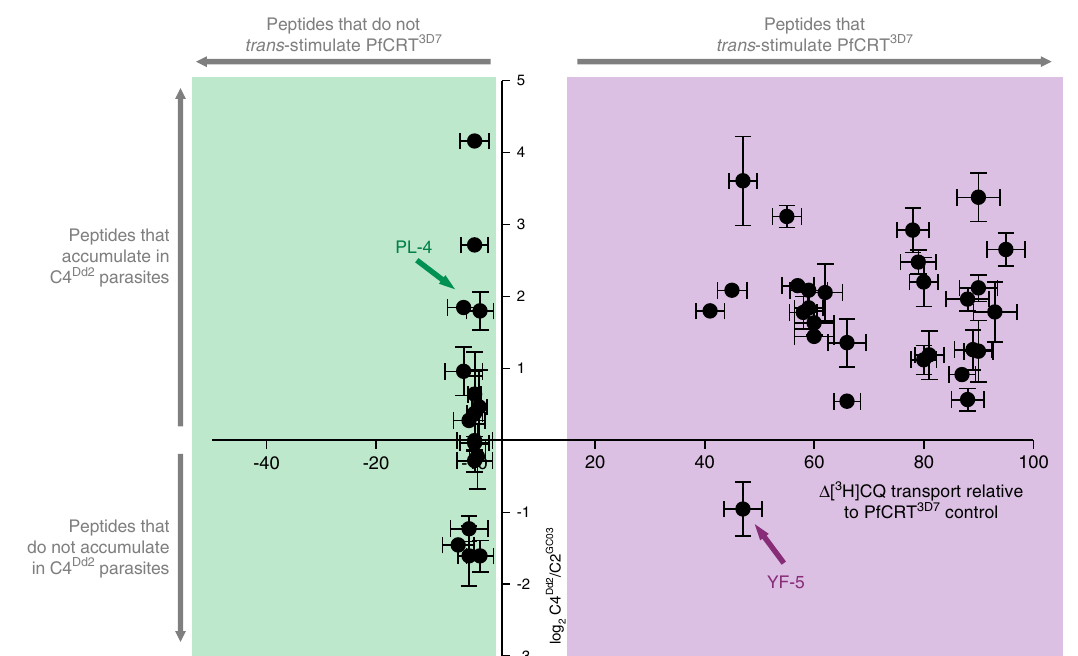
Fig. 7 The peptide substrates of PfCRT accumulate in parasites expressing mutant isoforms of the transporter. Host-derived peptides in erythrocytes infected with C2 GC03 or C4 Dd2 parasites were quanti fi ed using tandem liquid-chromatography mass-spectrometry and the peptide levels within the C4 Dd2 line were expressed relative to those measured in the C2 GC03 parasites (Supplementary Data 3 and 5). For peptides containing 4 – 11 residues, a positive relationship exists between the ability to trans -stimulate CQ transport via PfCRT 3D7 and accumulation within the CQ-resistant C4 Dd2 parasites. The analysis used the PfCRT 3D7 trans -stimulation dataset, rather than that generated for PfCRT Dd2 , because the peptides most likely to accumulate in the C4 Dd2 line will include those that are very poor substrates of (or no longer transported by) PfCRT Dd2 . An analysis of the data with a Bayesian Information Criteria model identi fi ed two distinct populations. The trans -stimulation data are the mean of four independent experiments (each yielding similar results) and the peptide accumulation data are the mean of 2 – 6 independent experiments (each yielding similar results). Error bars are shown for data points that are n ≥ 3; the Y error is the SD and the X error is the SEM. The source datasets are provided as a Source Data fi le.